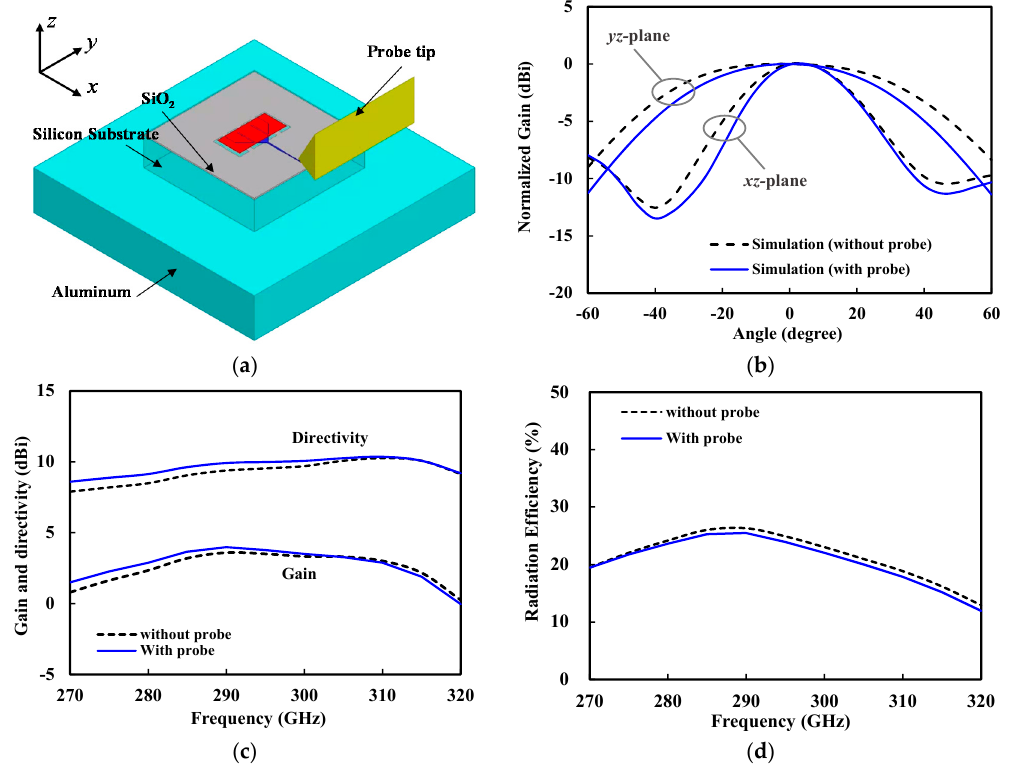
Figure 9. ( a ) Electromagnetic (EM) simulation of the on-chip antenna with the probe tip included. ( b ) Simulated radiation pattern at 300 GHz. ( c ) Simulated gain and directivity. ( d ) Simulated radiation efficiency.